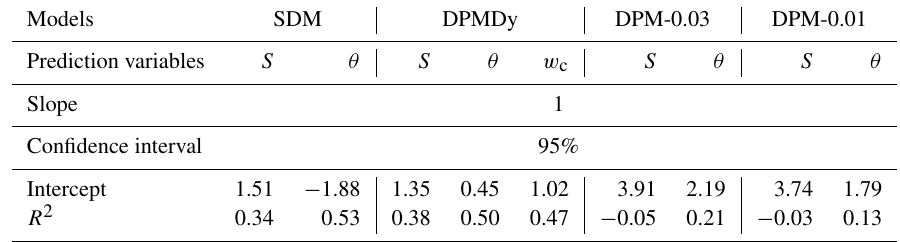
Table 4. Summary of fitting performance of different models to measured data.